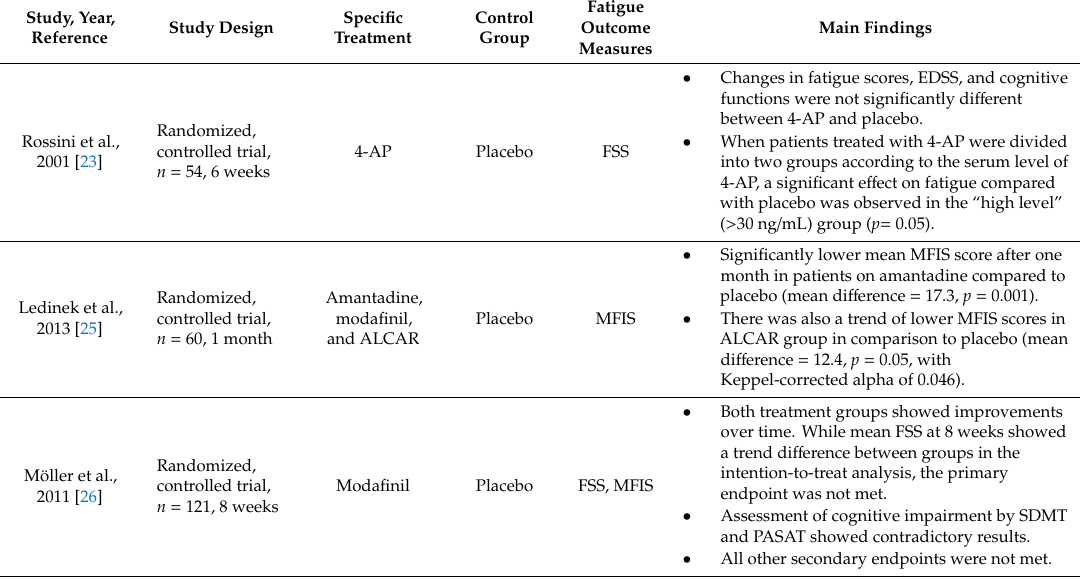
Table 1. Neurological standards for the pharmacological treatment of